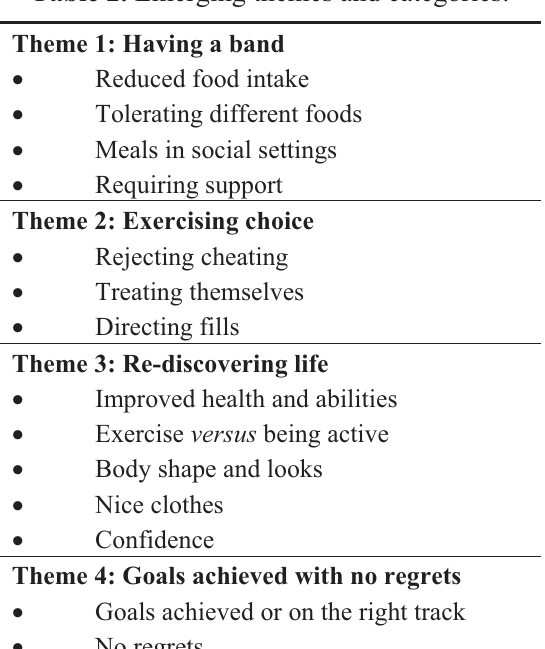
Table 2. Emerging themes and